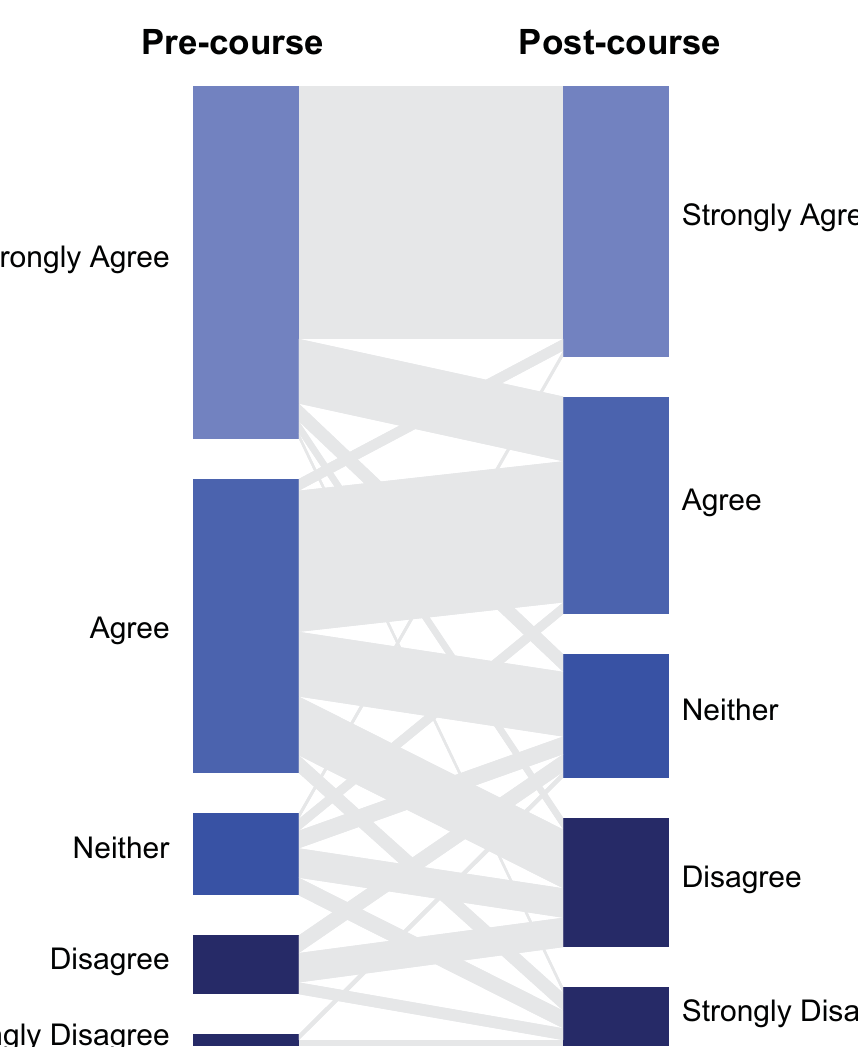
Fig 5. Migration of student attitudes toward biology. Most students maintained a positive view of the subject, though the percentage of students who were uninterested did increase. Students who became less interested were primarily those who were not planning to major in STEM